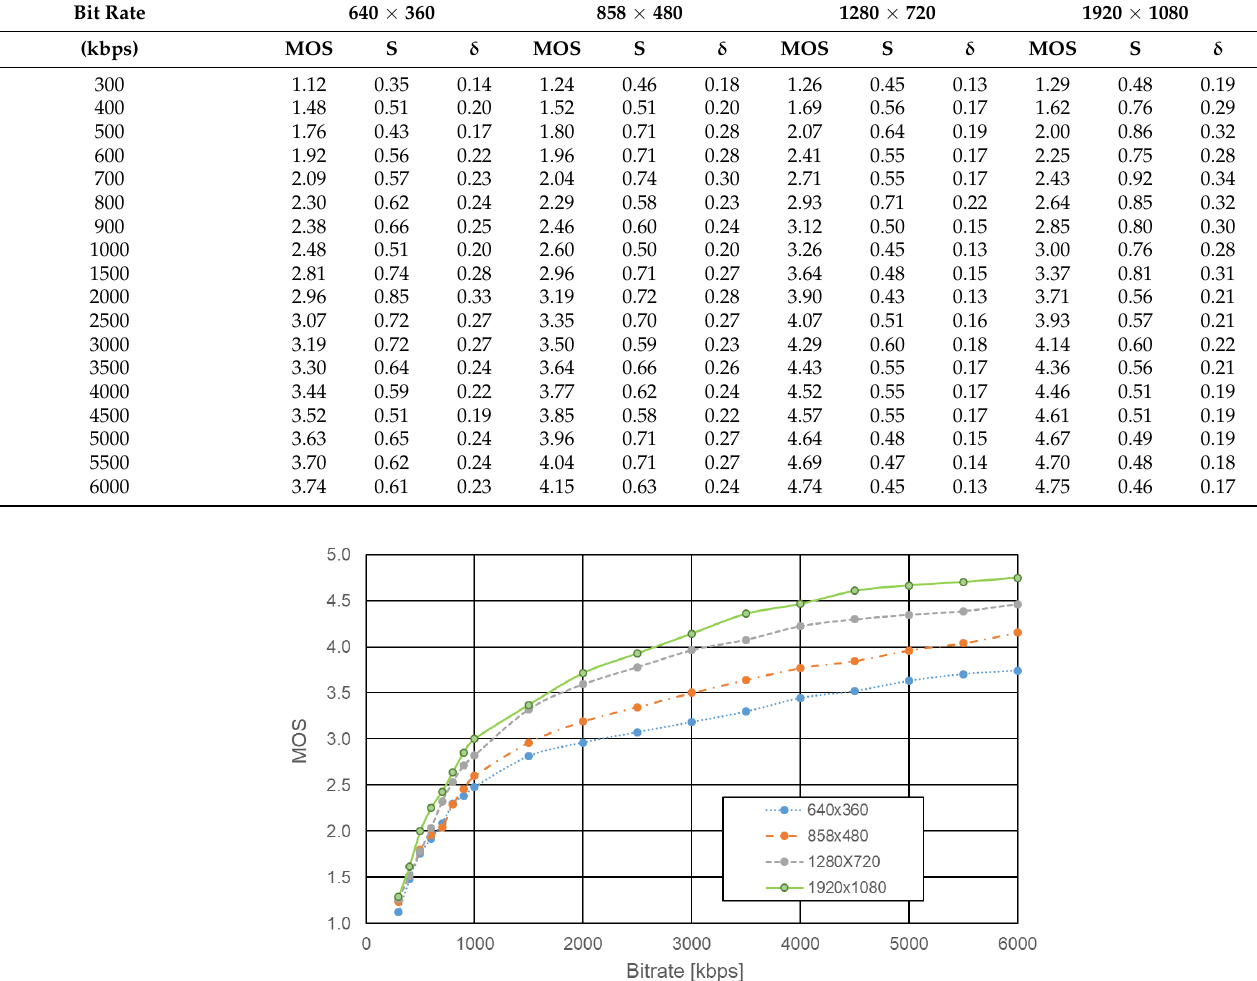
Table 8. Mean value of the video quality assessment (MOS) for VP9 codec, standard deviation (S), and confidence interval coefficient (δ) for four resolutions—measurements in laboratory.